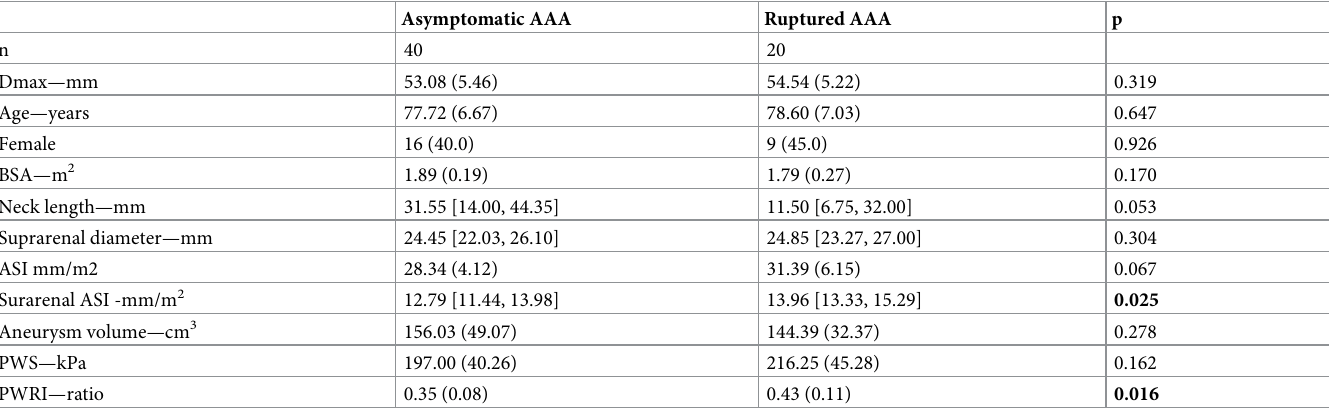
Table 4. Diameter-, sex- and age-matched analysis of small ruptured abdominal aortic aneurysms and asymptomatic controls. Asymptomatic